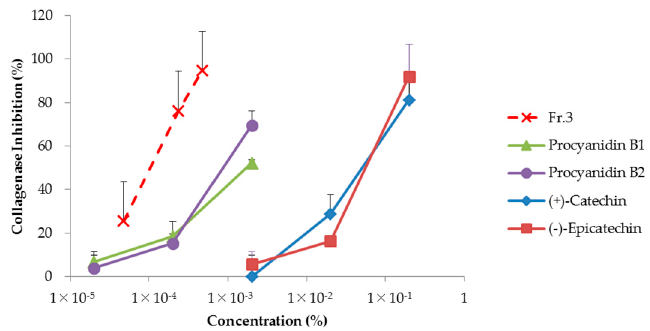
Figure 7. Collagenase inhibition effect of sarcocarps Fr.3, catechins, and procyanidins. Samples were dissolved in distilled water to the appropriate concentration, and the collagenase inhibition was determined. The sample concentration is described as the solid concentration. Results are expressed as the mean ± SD (n = 3–4).